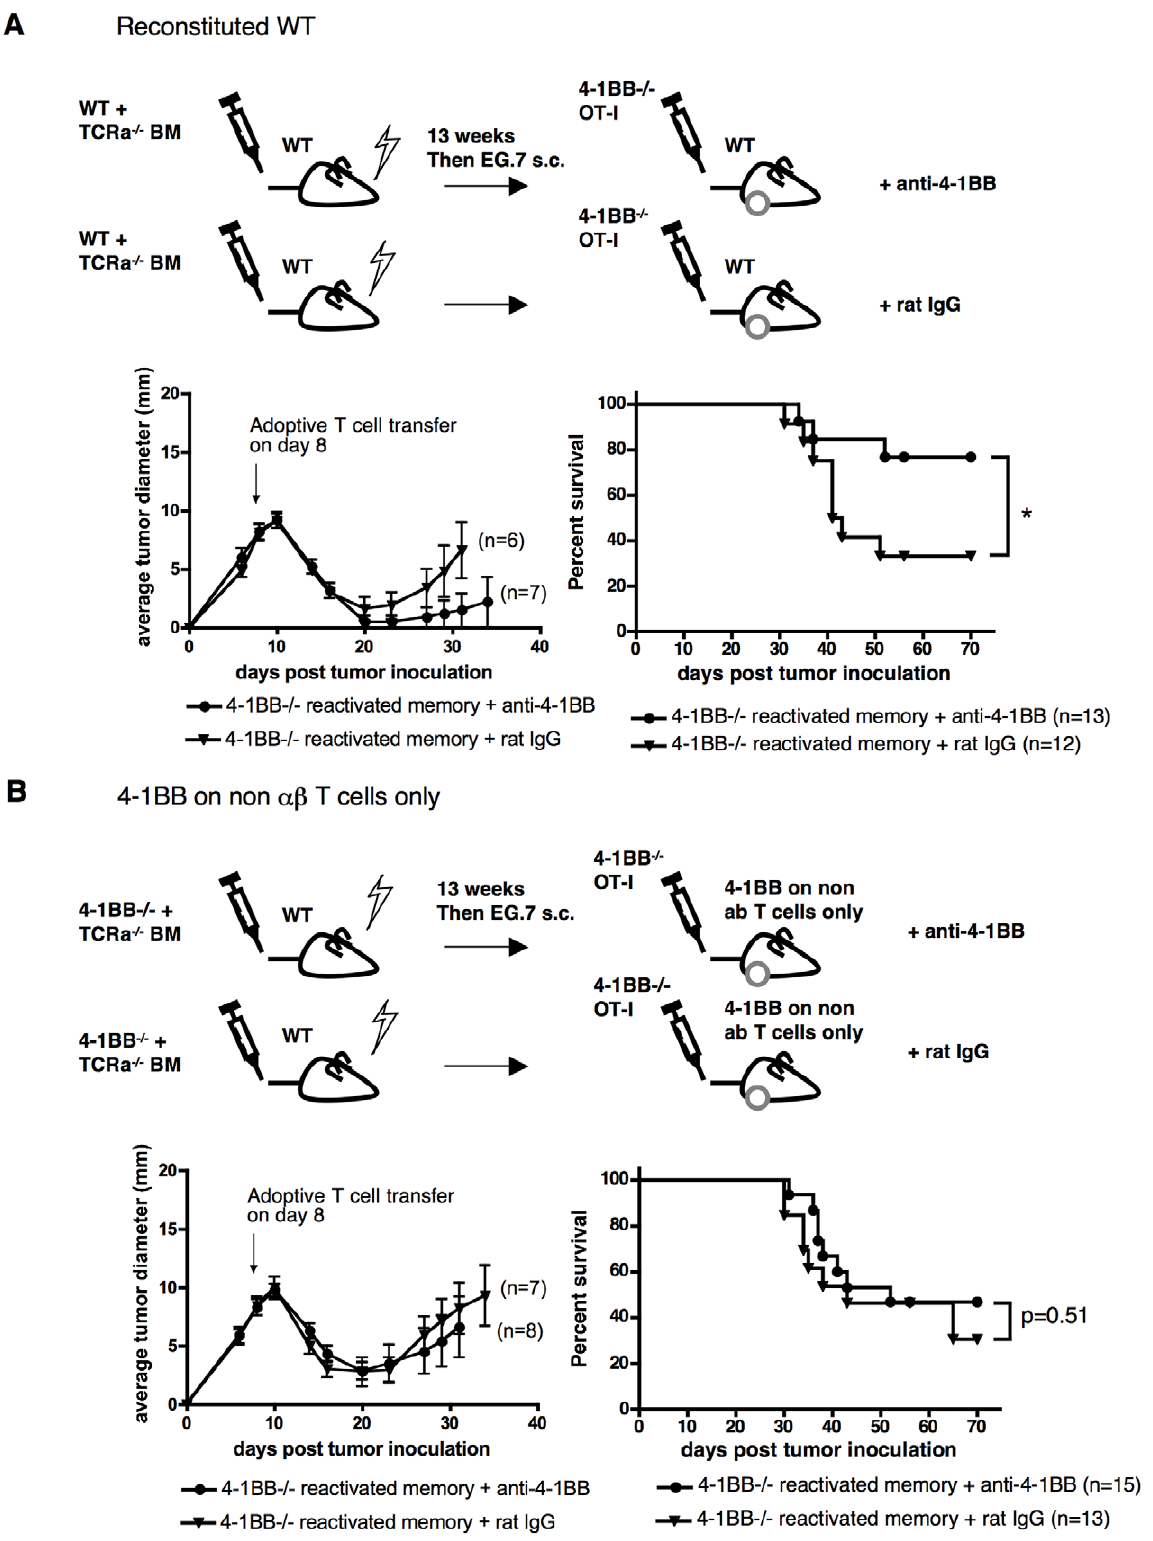
Figure 7. 4-1BB on non- ab T cells in the host is insufficient for anti-4-1BB mediated tumor control. Mixed bone marrow chimeras were generated by reconstituting lethally irradiated C57BL/6 WT mice with a 4:1 mixture of TCR a 2 deficient: WT or 4-1BB 2 / 2 bone marrow cells as illustrated. 13 weeks post reconstitution, chimeric mice were inoculated with E.G7 cells s.c. and 8 days later were treated with reactivated 4-1BB 2 / 2 OT-I, followed by two doses of anti-4-1BB or rat IgG treatments as in Figure 6B. Average tumor growth and survival are shown (n=number of mice per group). Tumor growth curves are representative of two independent experiments with 6–7 mice per group each. Survival curves include the combined survival data from the two independent experiments.